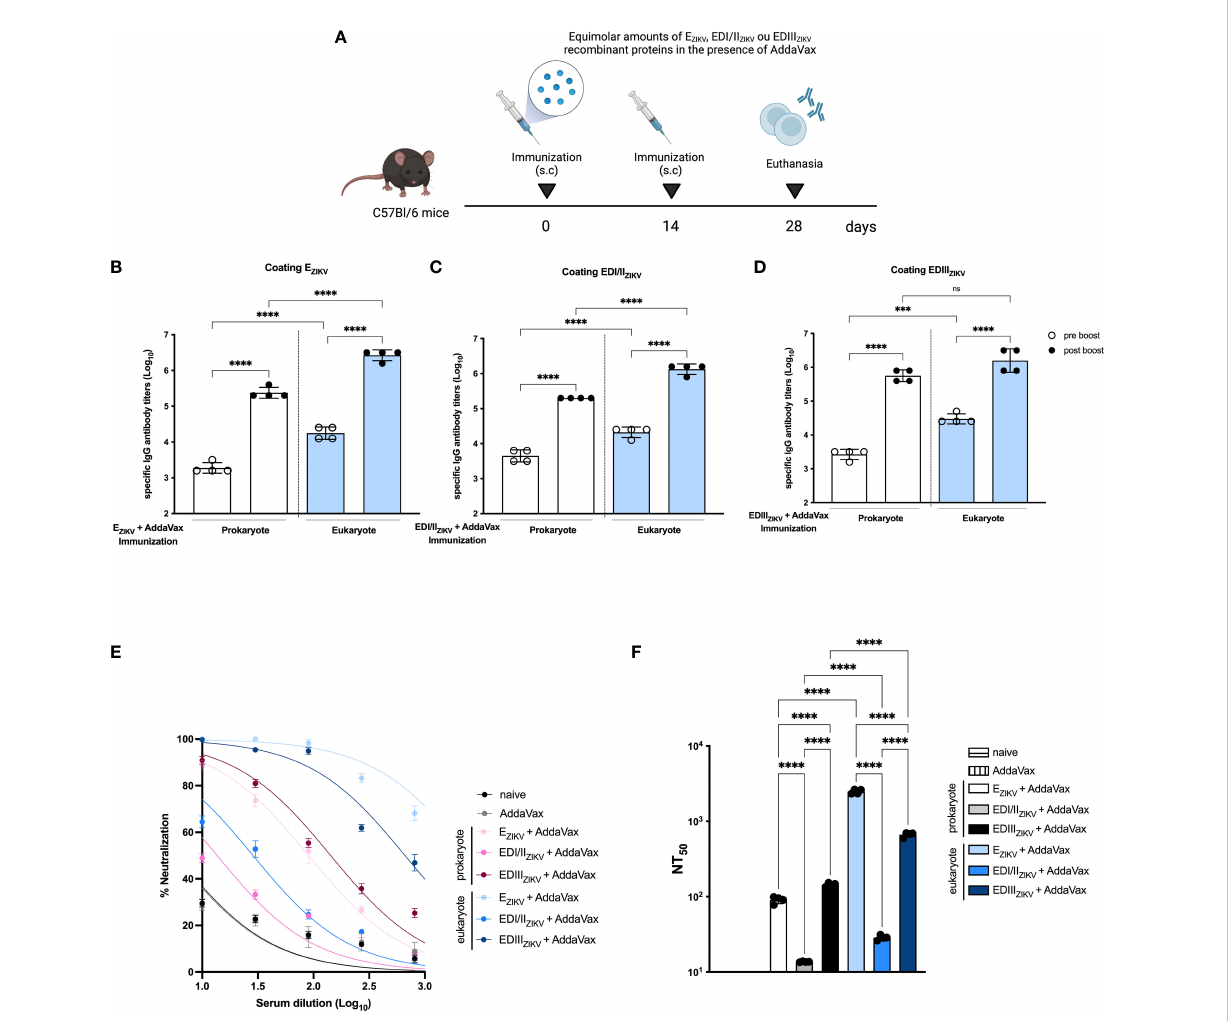
FIGURE 2 Immunogenicity of ZIKV antigens produced in prokaryotic or eukaryotic cells. (A) Immunization strategy (created with Biorender.com). C57Bl/6 mice (n=3 control groups and n=4 experimental groups) received two doses of recombinant antigens (E ZIKV , EDI/II ZIKV or EDIII ZIKV ) in the presence of AddaVax by subcutaneous route. Mice were bled 14 days after each dose to evaluate speci fi c antibody responses by ELISA. Total speci fi c IgG antibody titers on logarithmic scales (Log 10 ) on groups that received prokaryote or eukaryote proteins: (B) E ZIKV , (C) EDI/II ZIKV or (D) EDIII ZIKV . (E) Virus neutralization activity of sera collected from immunized mice represented by percentages and (F) 50% ZIKV neutralization titers (NT50) of the sera collected from mice after immunization with prokaryote or eukaryote E ZIKV , EDI/II ZIKV and EDIII ZIKV . Neutralization capacity of naïve or animals that received only adjuvant is also indicated. Statistical signi fi cance was measured by One-way ANOVA followed by Tukey ’ s post hoc test, ***p<0.001, ****p<0.0001, ns, not signi fi cant. Data represent mean ± SD and are representative of 3 independent